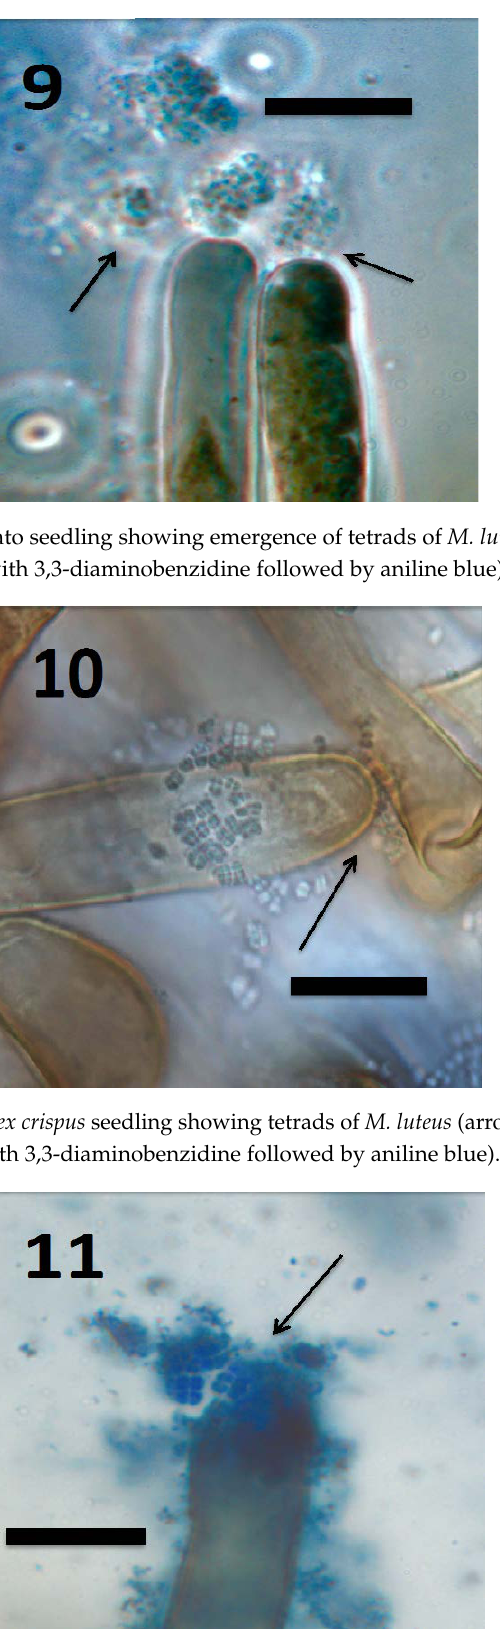
Figure 11. Root hair of seedling of grass Cynodon dactylon showing tetrads of M. luteus (arrow) emerging from ruptured root hair tip (bar = 15 µm; stained with 3,3-diaminobenzidine followed by aniline blue).